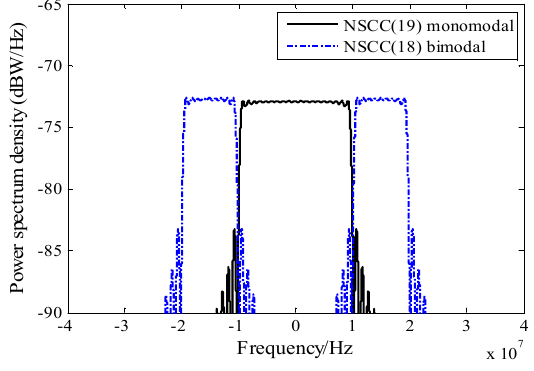
Figure 1. Comparison of PDSs for NSCC baseline structures.